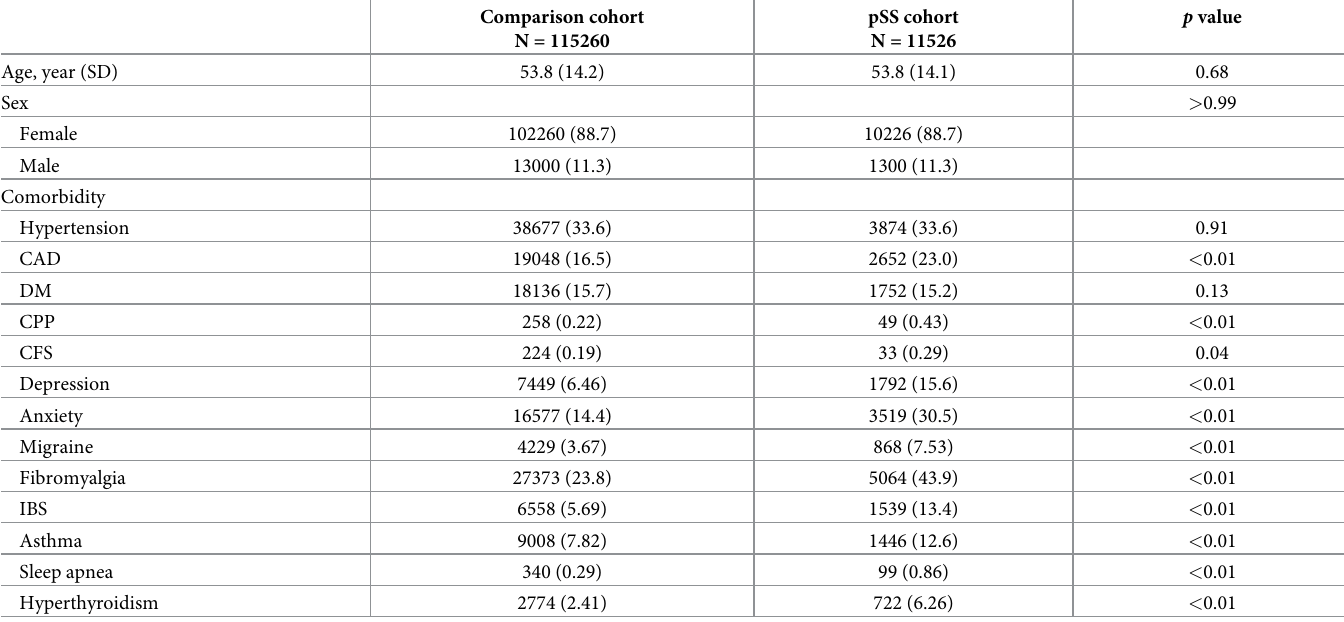
Table 1. Comparisons of demographic data between pSS and comparison cohorts.